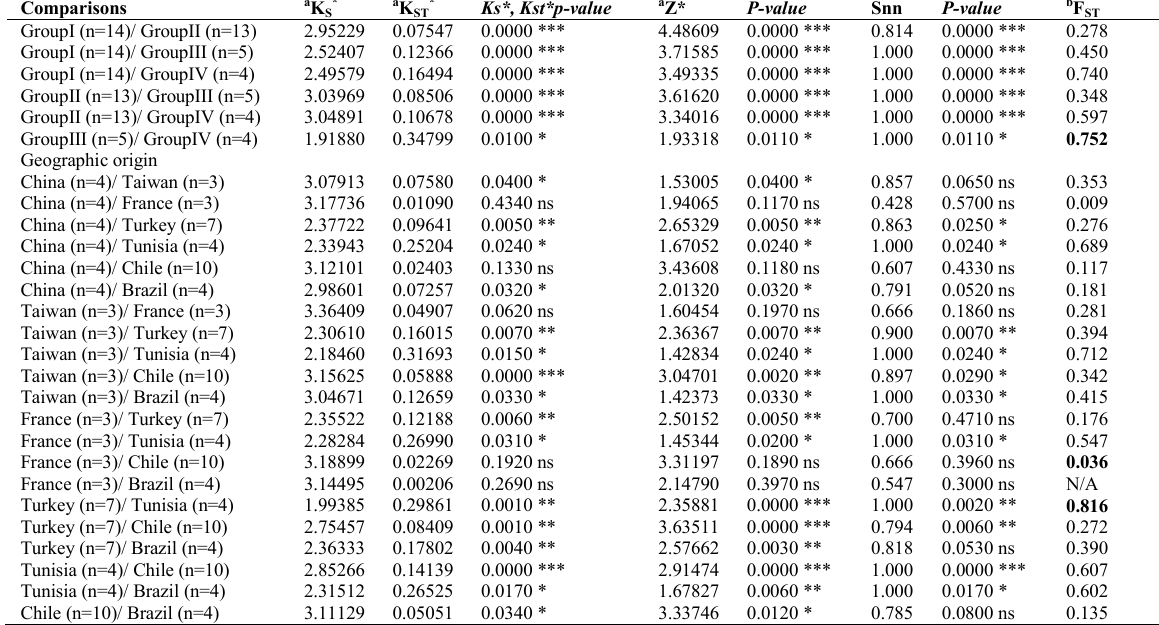
Table 4. Summary of gene flow and genetic differentiation estimates between populations of LMV based on the CP.